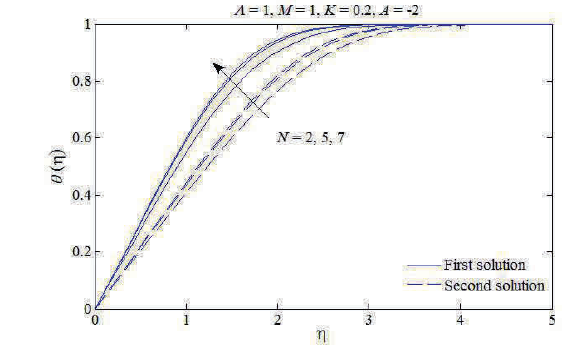
Fig. 14: Temperature profiles for different values of N